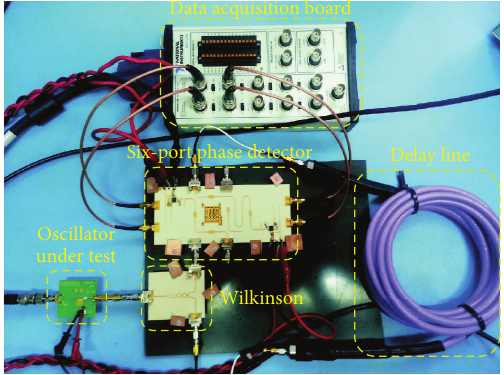
Figure 8: Six-port-based delay line frequency discriminator proto-